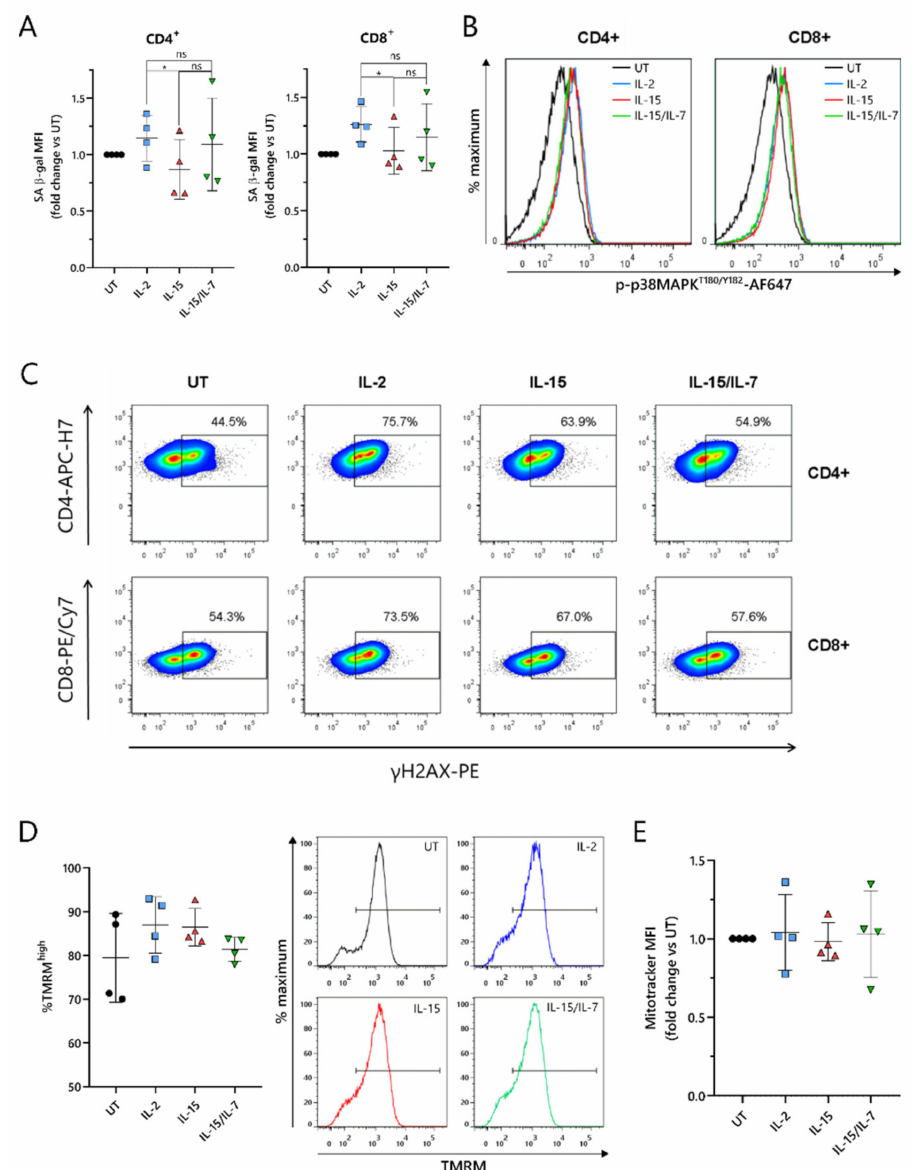
Figure 6. IL-15 induces lower levels of DNA damage in ARI2h BCMA-CARs compared to IL-2 while maintaining high mitochondrial function. ( A ) Summary of the senescence-associated β -galactosidase (SA- β -gal) activity of day 9 in vitro- cultured UT or CAR + CD4 + and CD8 + T cells, based on the MFI of the signal and normalized to UT. ( B , C ) Phosphorylation of p38 MAPK on threonine 180/tyrosine 182 ( B ) or γ H2AX expression ( C ) in UT or CAR + CD4 + and CD8 + day 9 in vitro- cultured T cells. Shown are representative histograms ( B ) ( n = 4) or representative FACS plots in which the numbers/gates show the percentage of γ H2AX + cells based on an FMO control ( C ) ( n = 4). ( D ) Left—Relative frequency of hyperpolarized (TMRM high ) cells within the populations of CD8 + (UT) or CAR + CD8 + (ARI2h IL-2 , ARI2h IL-15 and ARI2h IL-15/IL-7 ) day 9 in vitro-cultured T cells. Right—Representative histograms ( n = 4). Gates show hyperpolarized (TMRM high ) cells. ( E ) Summary of the MitoTracker Deep Red FM staining in UT CD8 + (UT) or CAR + CD8 + day 9 in vitro-cultured T cells, based on MFI and normalized to UT. * p < 0.05; ns, not